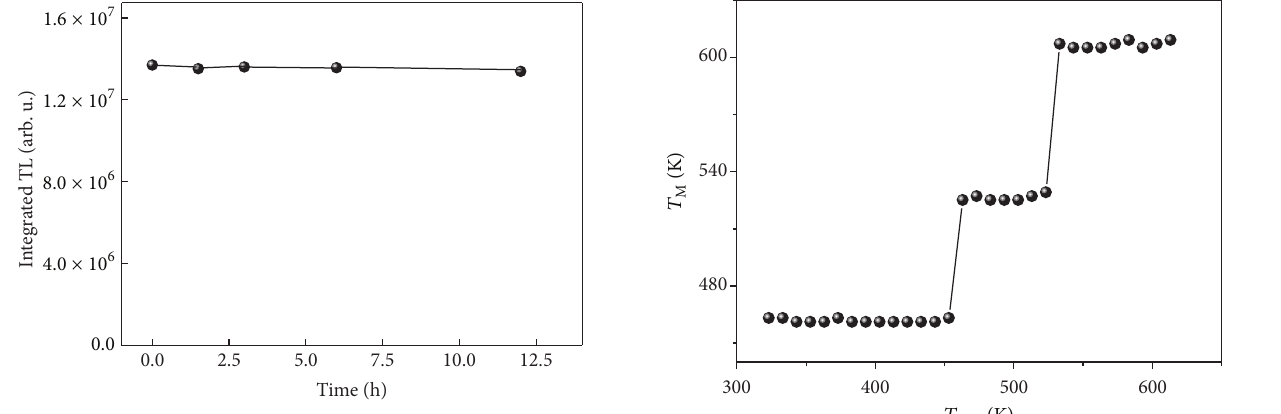
Figure 7: Integrated thermoluminescence (TL) as a function of the time interval elapsed between irradiation and the corresponding TL readout.